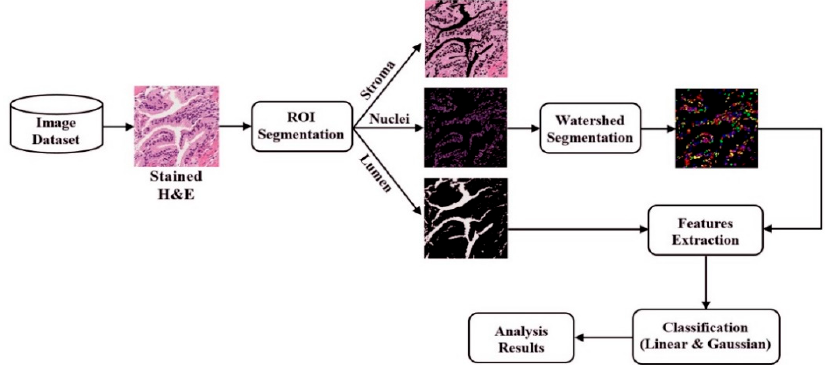
Figure 2. Proposed pipeline model for predicting cancer grading from microscopic biopsy images.